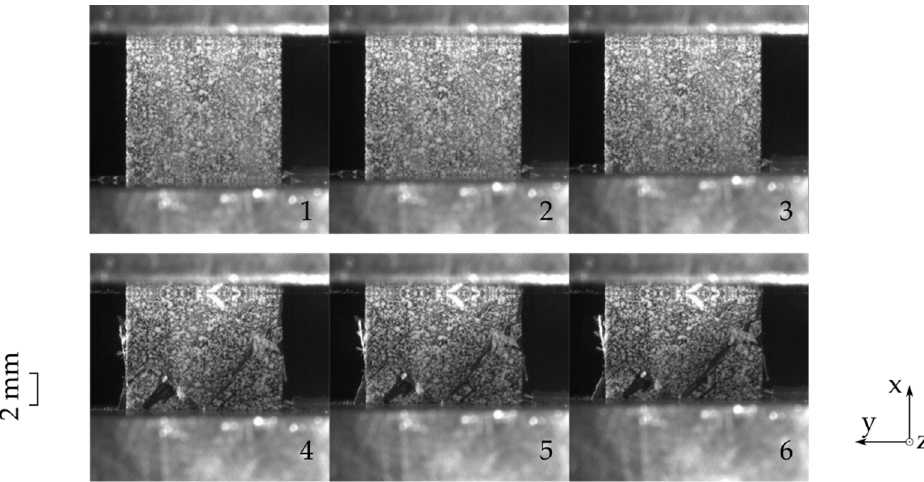
Figure 2. Progressive failure in a 0° loaded [45,-45,0] s laminate observed from the front view ( 1 – 6 chronologically obtained images).